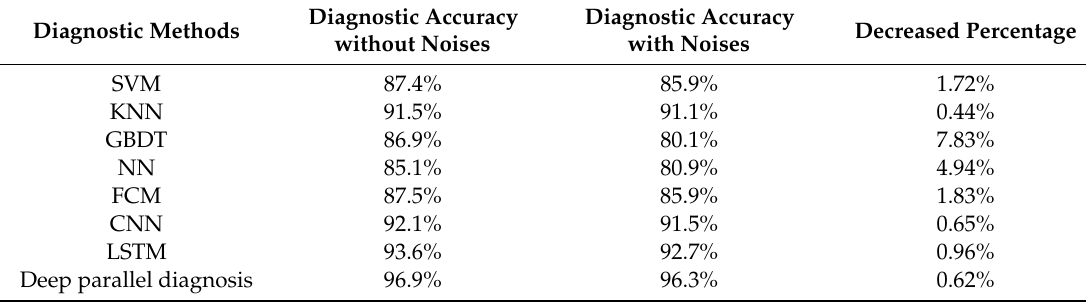
Table 8. Diagnostic e ff ects of di ff erent diagnostic methods with or without